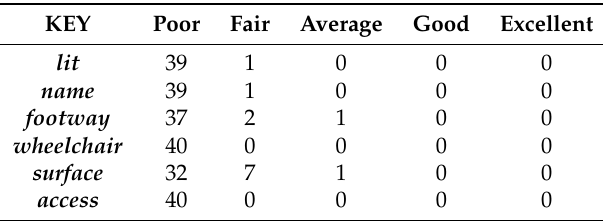
Table 6. Summary of compliance of all cities with suggested tag key combinations for the target tag highway=footway